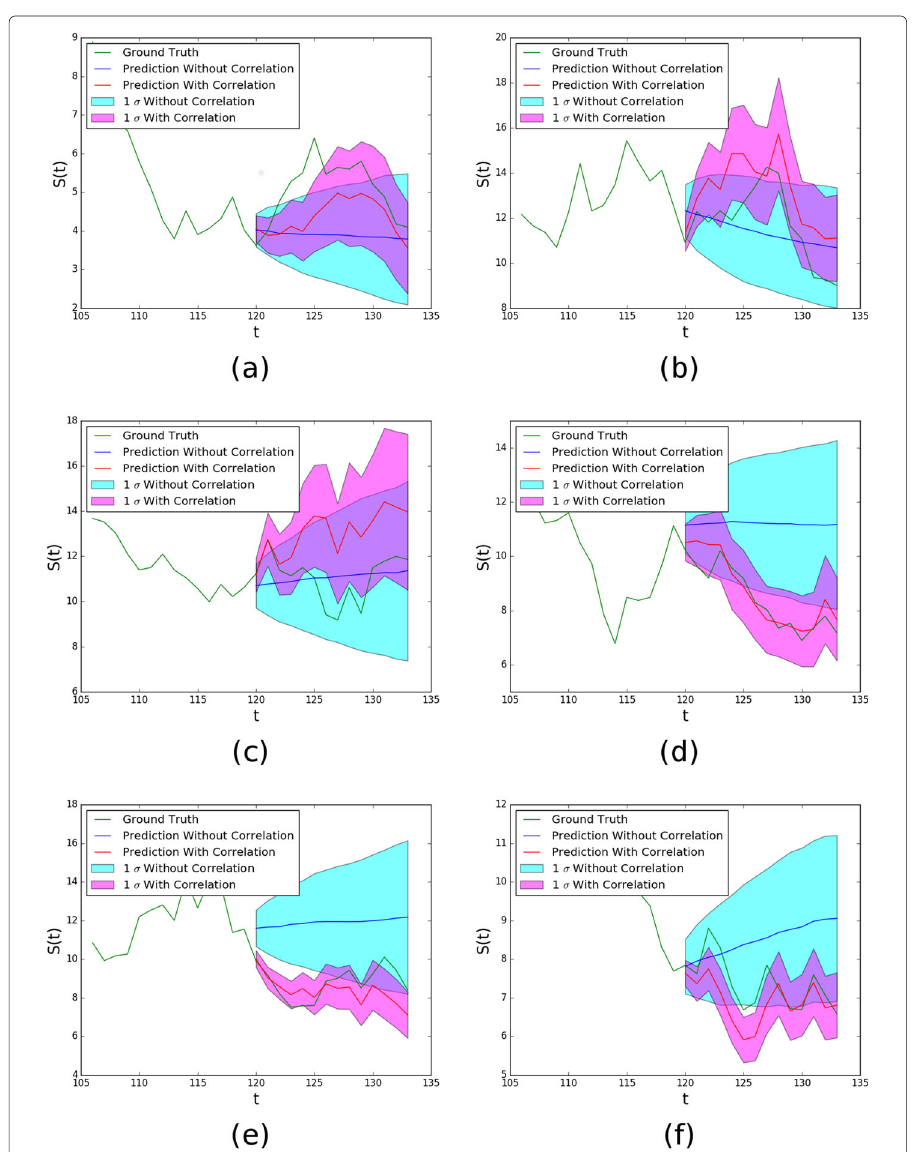
Fig. 2 Predictions of simulated data using various models and correlations by masking the last 14 data points. Our prediction with correlation uses 11 other correlated time series, and we made a prediction assuming no correlation with those time series. A training window of 120 time steps was used in each case. ( a , c , e ) use GBM and ( b , d , f ) use GOU. ( a , b ) use a correlation matrix with all off-diagonal elements of the correlation matrix equal to .4 with ( c , d ) using .6 and ( e , f ) using .8. Estimated parameters and correlations for these examples can be seen in Table 4 (Appendix